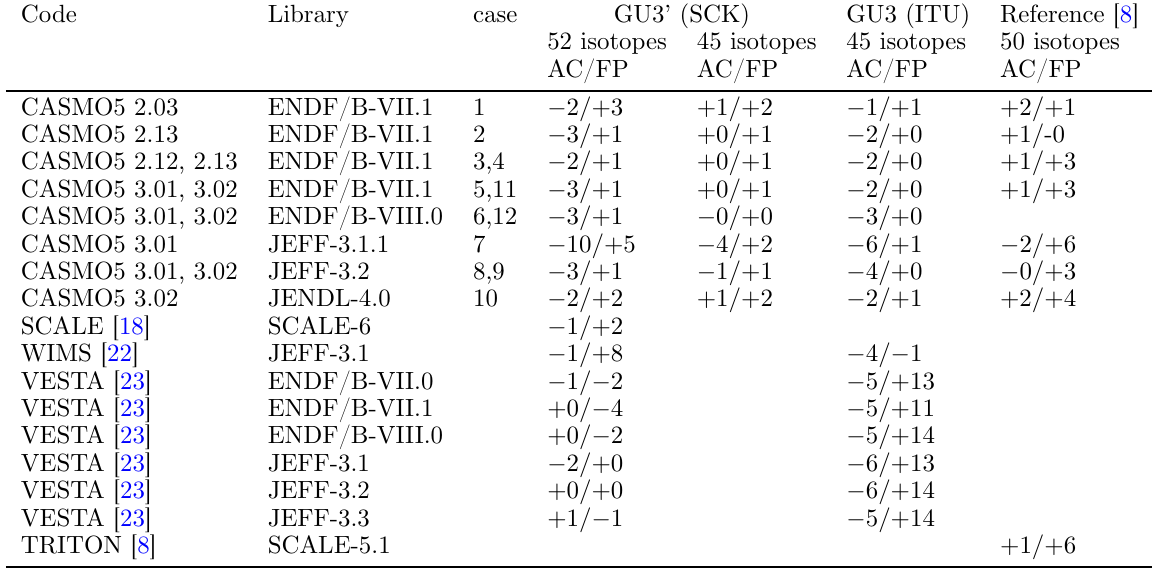
Table 2. Comparison of average C/E-1 (in%) between different types of calculations for GU3 and GU3’, see text for